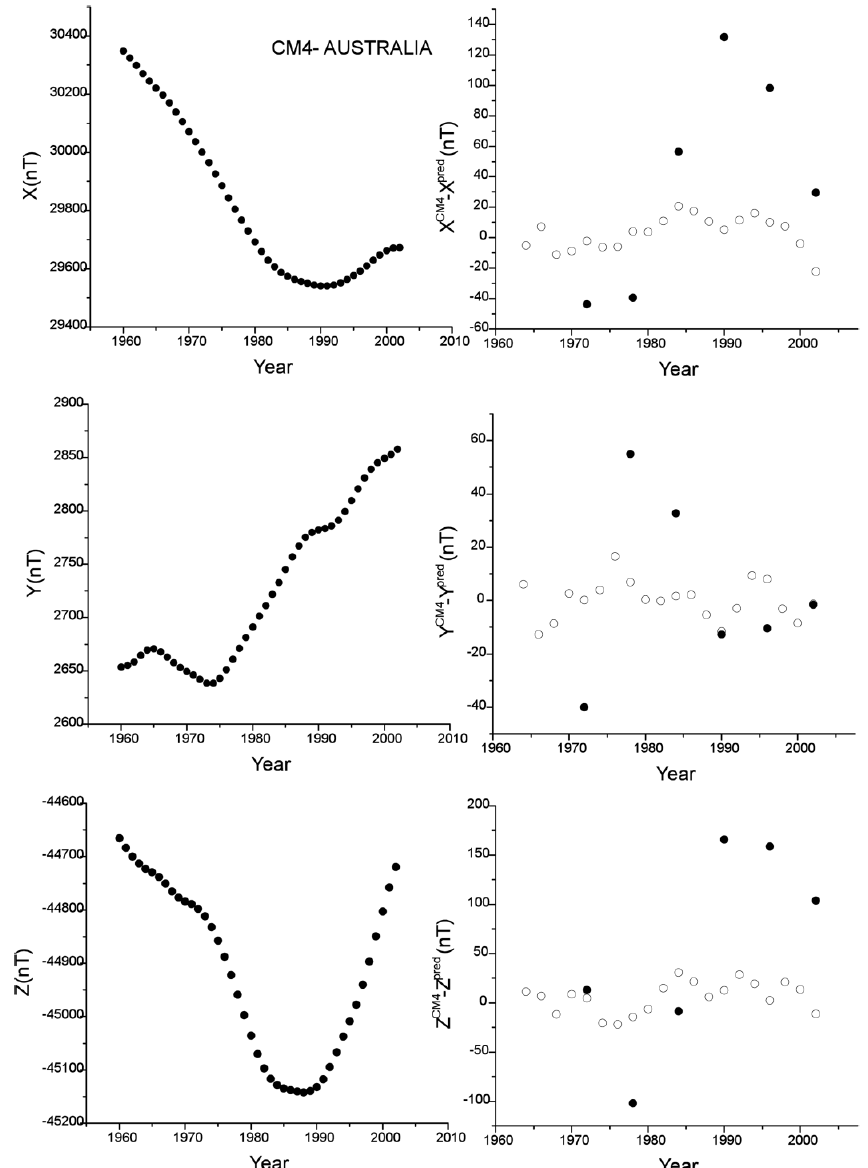
Figure 5. Left: Synthetic case of possible repeat-station time series of the geomagnetic component in a central point in Australia, as deduced from the CM4 model. Right: Differences between the synthetic (actual) values and the predicted values when the frequency of repetition is one data point every 2 years (white circles) and 6 years (black